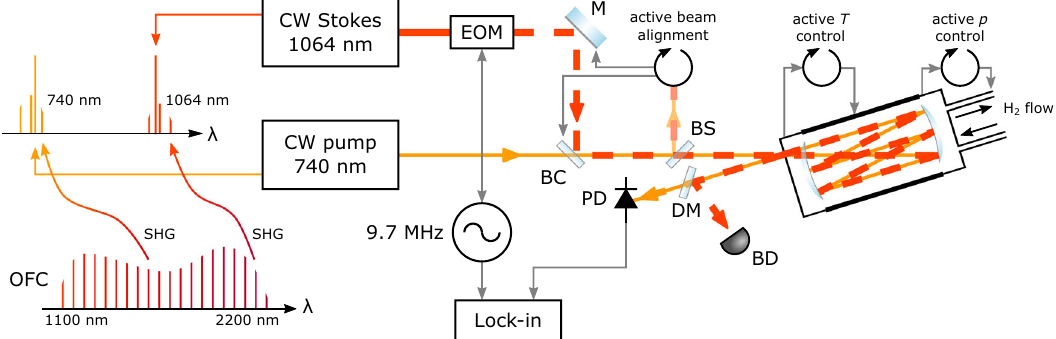
Fig. 1 Comb-assisted stimulated Raman scattering. EOM electro-optic modulator, M mirror, BC beam combiner, BS beam sampler, DM dichroic mirror, BD beam dumper, PD photodiode, OFC optical frequency comb, SHG second-harmonic generation. Comb referencing of pump and Stokes lasers is obtained through second-harmonic generation of selected spectral portions of an octave-spanning continuum generated by an Er: fi ber comb (see “ Methods ” for